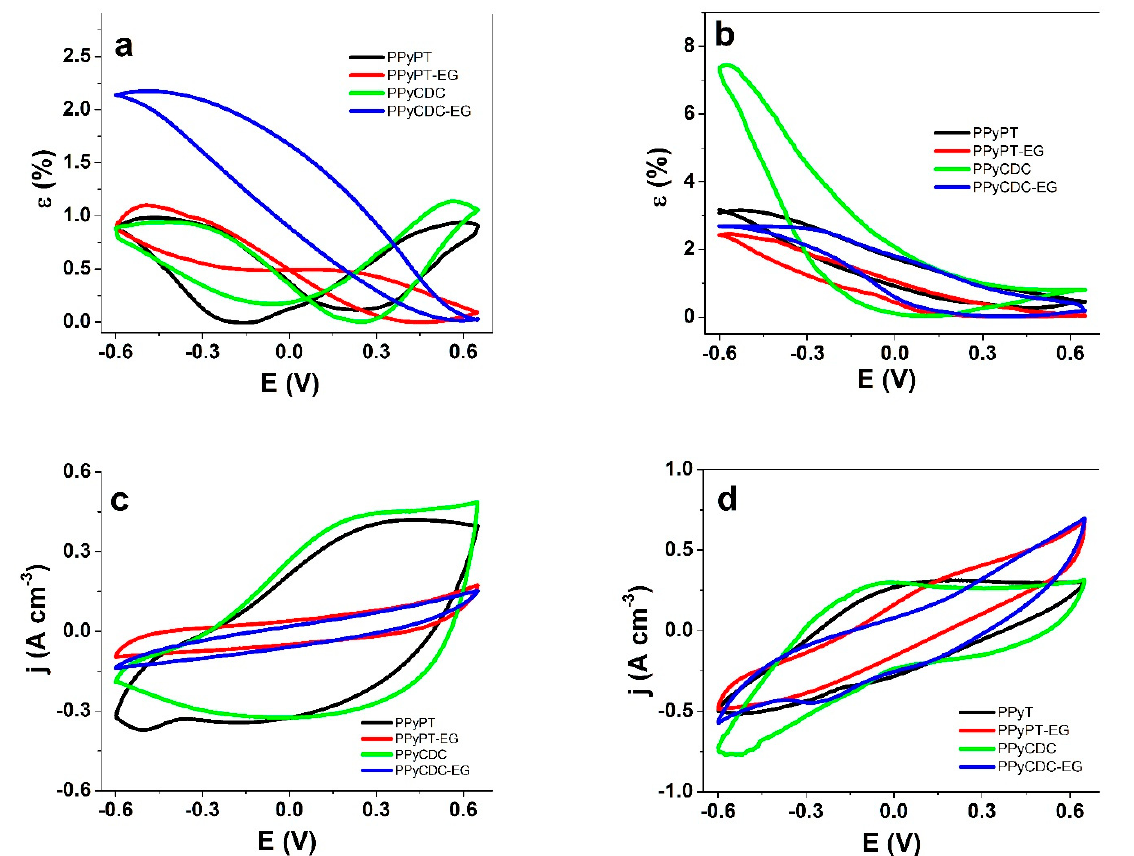
Figure 4. Cyclic voltammetry (scan rate 5 mV s − 1 ) of PPyPT (black line), PPyPT-EG (red line), PPyCDC (green line) and PPyCDC-EG (blue line) at applied potential range 0.65 to − 0.6 V, showing strain ε against potential E of ( a ), in NaClO 4 -PC and in ( b ), NaClO 4 -aq electrolyte, in ( c ), the current density potential curves of PPy composites in NaClO 4 -PC and ( d ), in NaClO 4 -aq.